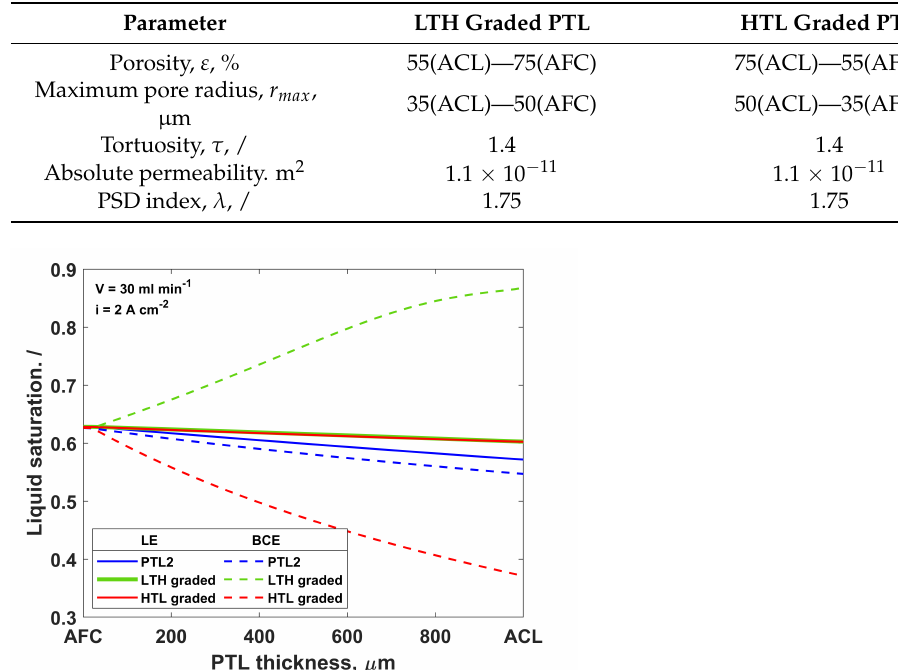
Figure 7. Liquid saturation through PTL thickness for graded and uniform PTLs at inlet flow rate 30 mL min − 1 and current density 2 A cm − 2 ; solid lines—LE simulation, dashed lines—BCE